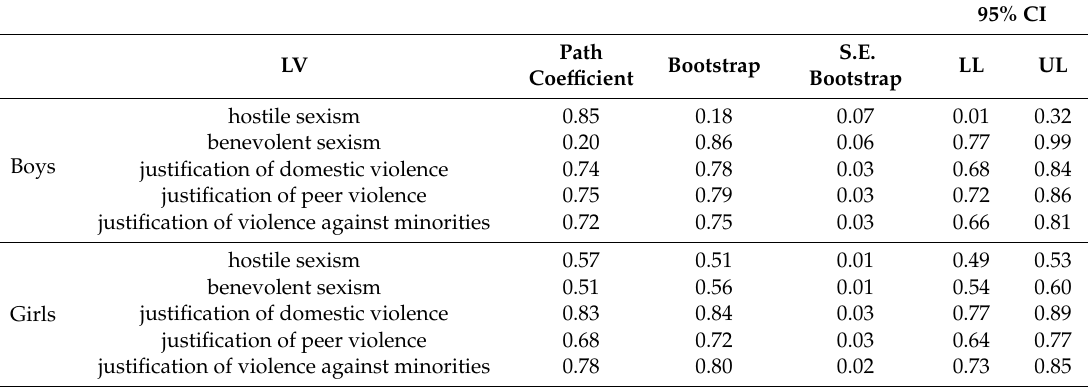
Figure 4. The estimated model. Table 3. Path coefficients—the mixed two step approach (boys and girls).